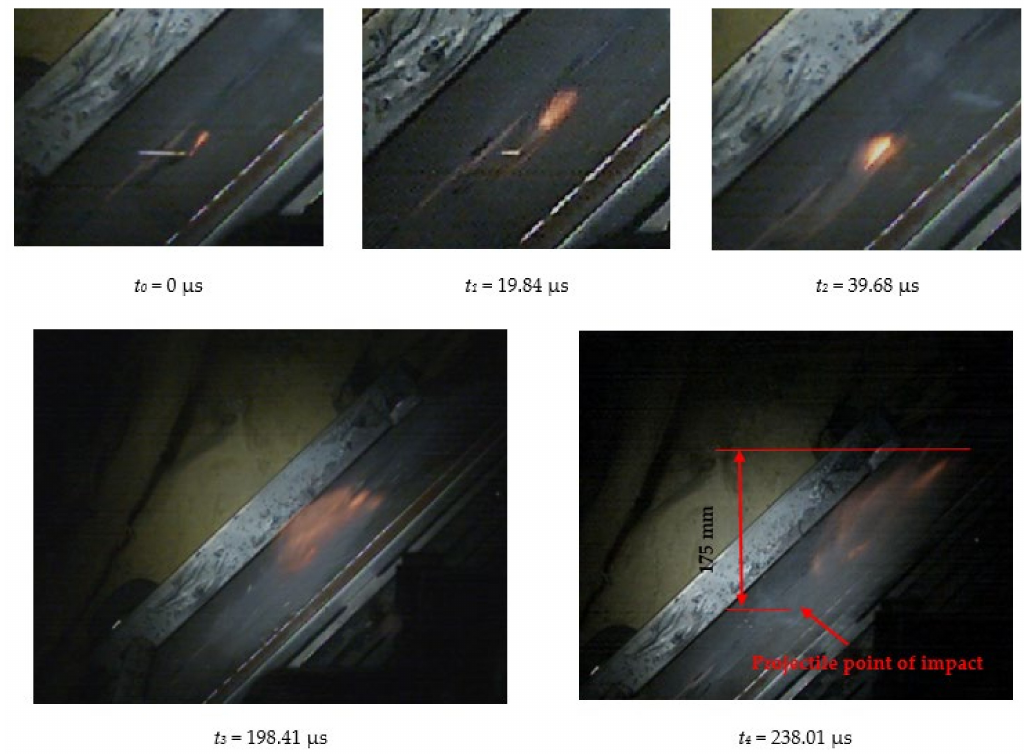
Figure 6. High-speed camera images of projectile impact onto armour plate.